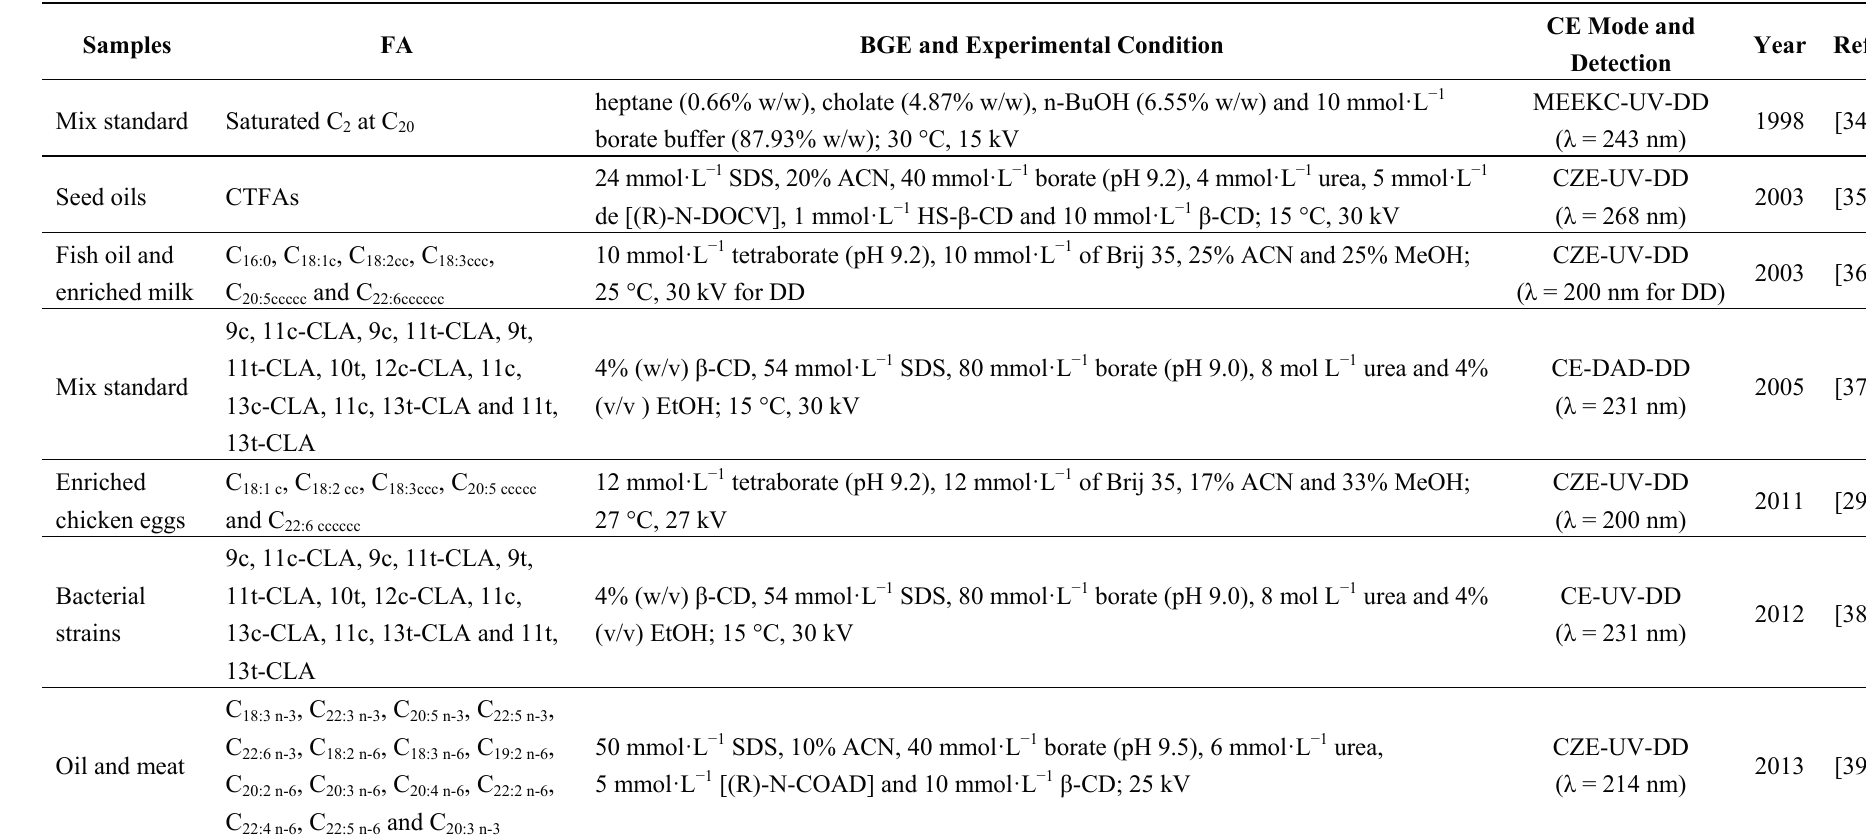
Table 1. Experimental condition, BGE and FA in different samples using UV-DD with different CE modes. CZE: Capillary zone electrophoresis. Samples FA